Question: What direction does the quantity move in — increasing or decreasing?
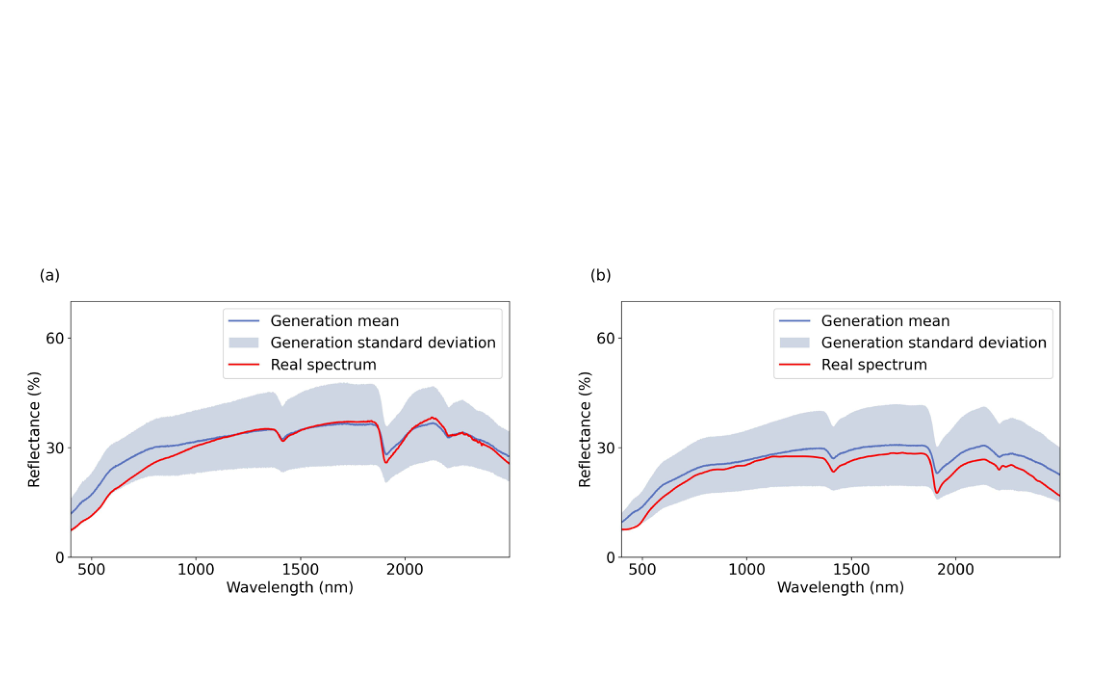
Answer: increasing